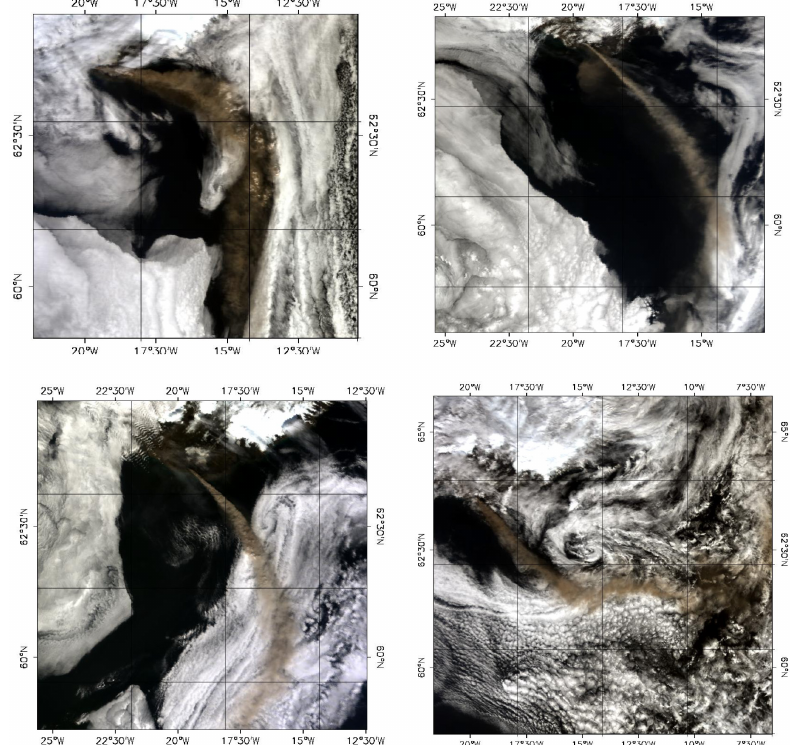
Figure 1. Training MODIS images RGB (R = ch1, G = ch4, B = ch3), used in this study. Top panel, from left to right: 6 May 2010, 11:55UTC; 7 May 2010, 14:30UTC. Bottom panel, from left to right: 8 May 2010, 13:20UTC; 13 May 2010, 12:00UTC.